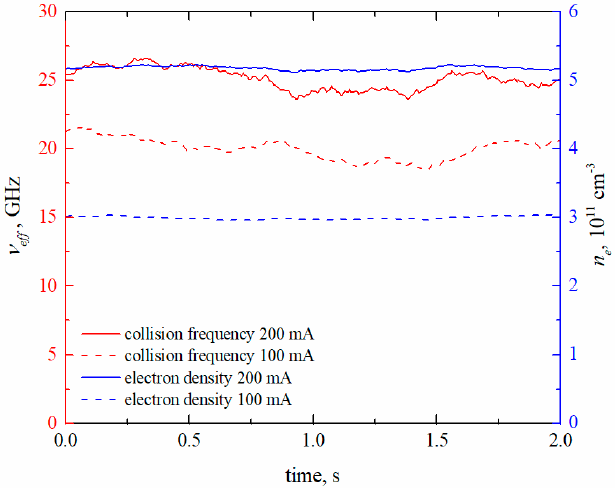
Figure 10. Time dependencies of the electron collision frequency and electron density for 100 and 200 mA discharge current values.